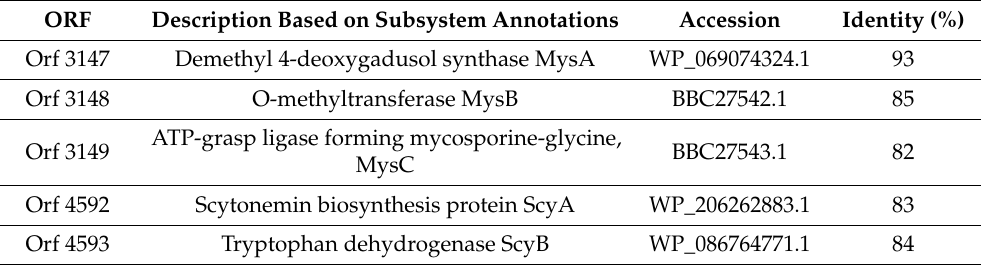
Table 1. Cyanocohniella sp. LLY open reading frames annotations and best Blast hit for MysABC and ScyABCDEF cluster genes.